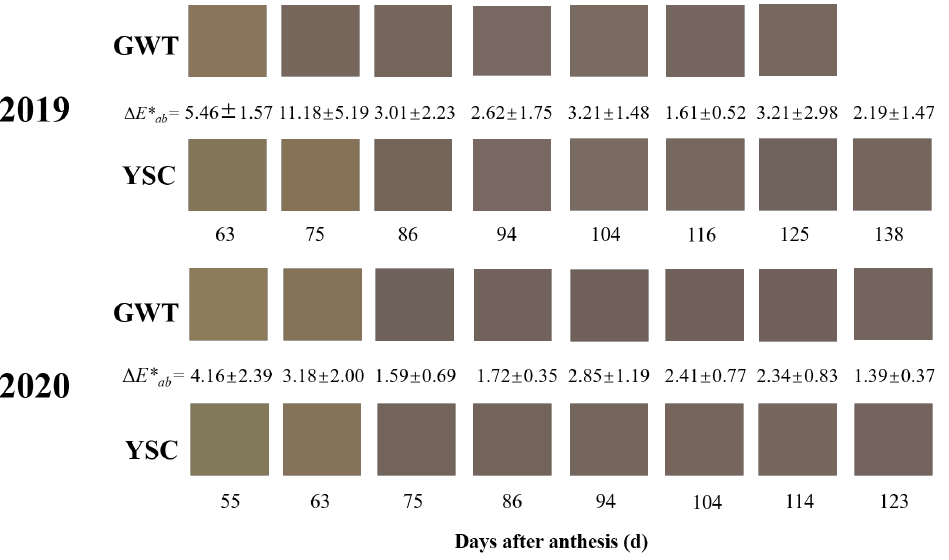
Figure 2. Color simulation plots of GWT and YSC grape seeds. ∆ E ∗ ab represents the color difference value between the seeds from the two vineyards in the same period.